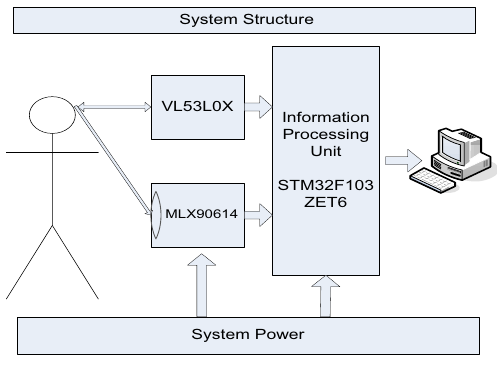
Figure 1. System Block